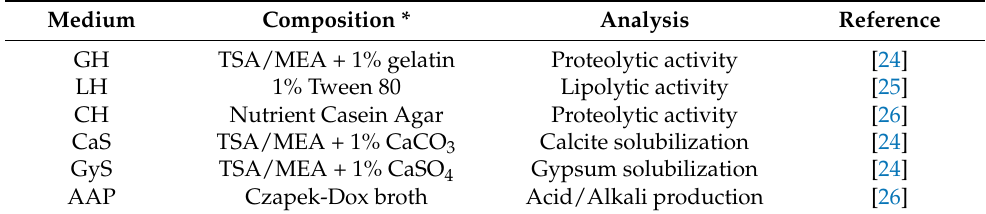
Table 2. Culture media and metabolic activities analyzed.